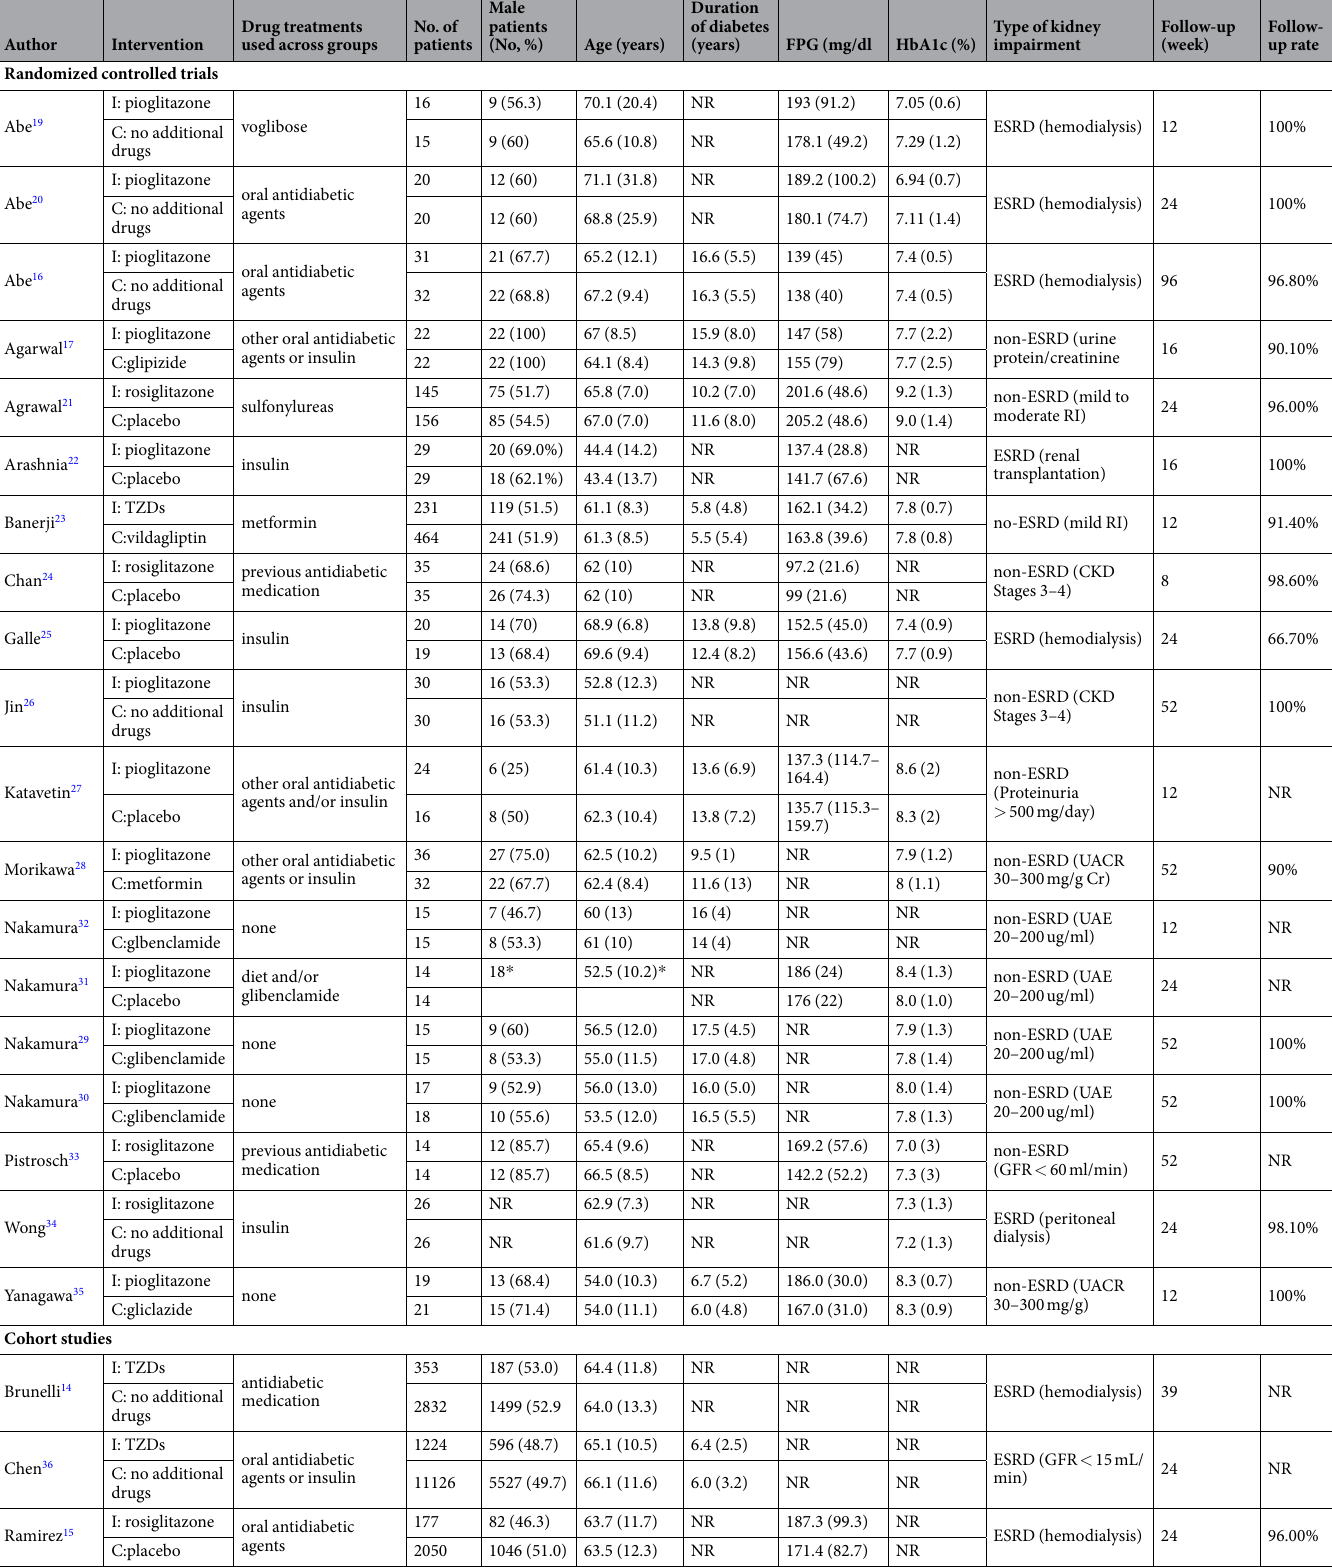
Table 1. Characteristics of included studies. Abbreviation: FPG = fasting plasma glucose, HbA1c = hemoglobin A1c, GFR = glomerular filtration rate, UACR = urinary albumin to creatinine ratio, UAE = urinary albumin excretion, ESRD = end-stage renal disease, NR = not reported. Continuous variables are presented as mean (standard deviation) or median (interquartile range). * Characteristics of total